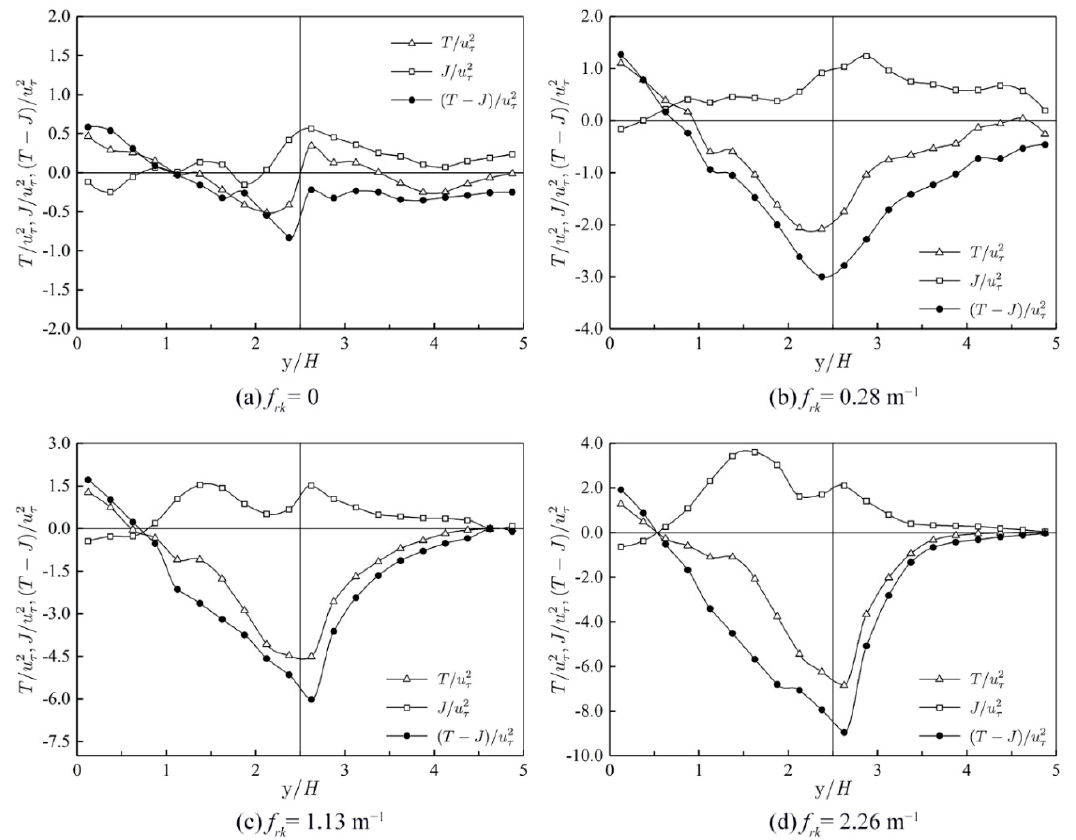
Figure 11. The apparent shear stress distribution with different floodplain vegetation densities. (a) Case with f rk =0. (b) Case with f rk =0.28m − 1 . (c) Case with f rk =1.13m − 1 . (d) Case with f rk =2.26m − 1 .